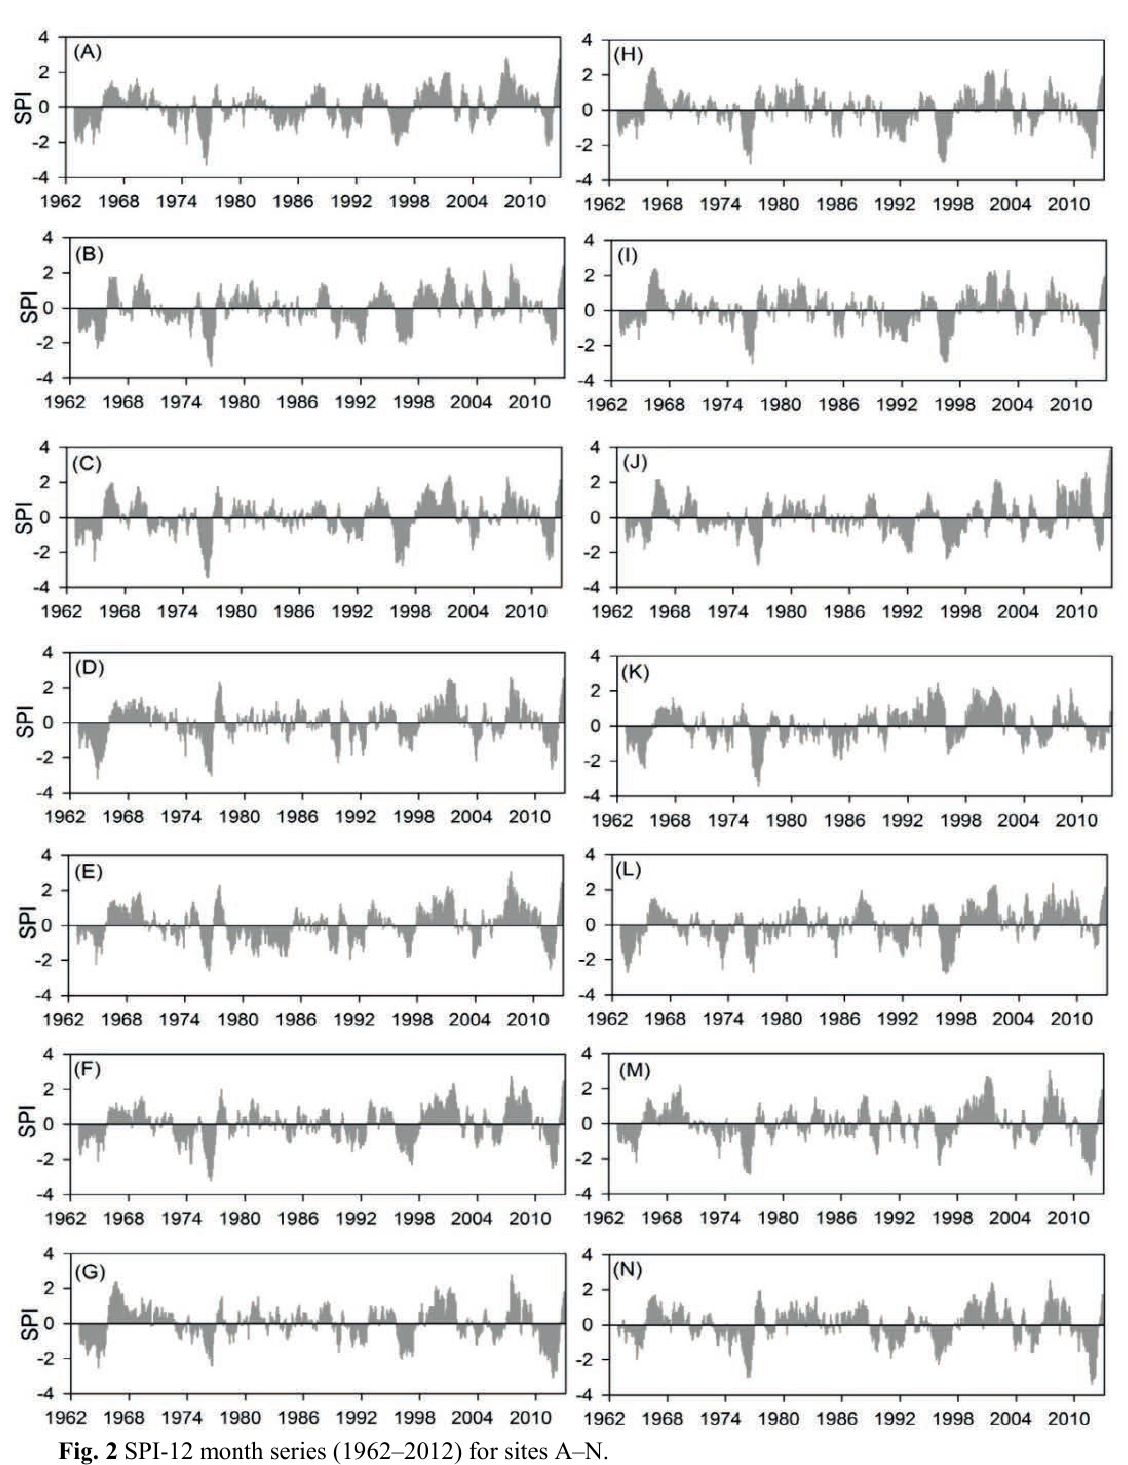
Fig. 2 SPI-12 month series (1962–2012) for sites